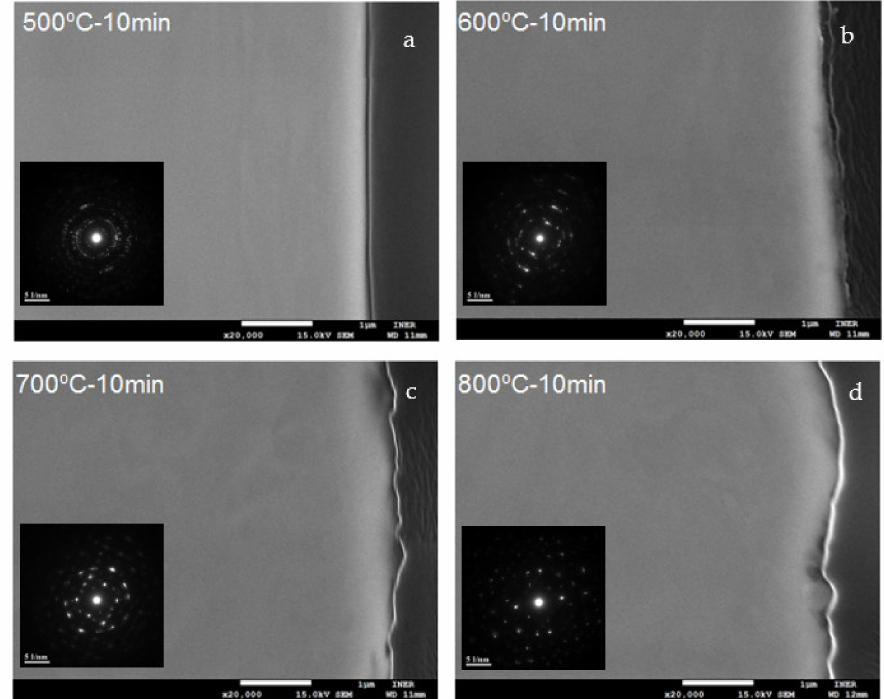
Figure 2. Cross-sectional SEM and TEM images of samples treated at ( a ) 500, ( b ) 600, ( c ) 700, and ( d ) 800 ◦ C for 10 min (scale bar: 1 µ m). The insets in the bottom left are the selected area diffraction patterns, with scale bars of 0.05 nm.